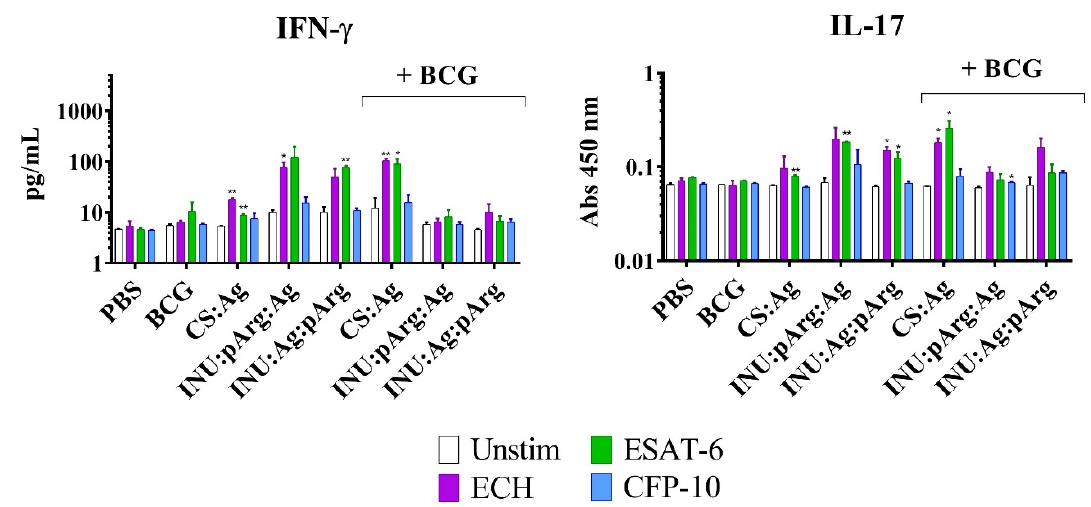
Figure 9. IL-17 and IFN-γ release from splenocytes of immunized mice after an antigen in vitro recall experiment. The splenocytes were incubated with CFP-10, ESAT-6, or the ESAT-6/CFP-10 fusion protein (ECH) and the supernatants were collected for cytokine measurement and were compared to the non-stimulated (Unstim) samples. Mice previously immunized with BCG (+BCG) or not, received PBS (as negative control), CS:Ag, INU:pArg:Ag, or INU:Ag:pArg as vaccine prototypes. IL-17: interleukin 17, IFN-γ: interferon gamma, Ag: Antigen, CS: Chitosan, INU: Inulin, pArg: Polyarginine. Statistical significance: * P ≤ 0.05, ** P ≤ 0.01, *** P ≤ 0.001.